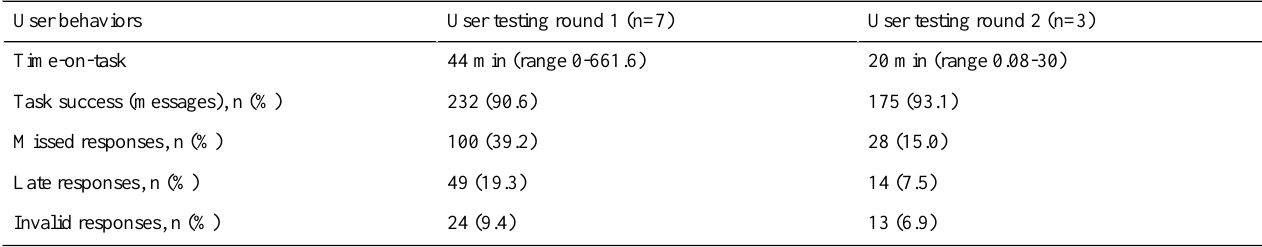
Table 5. Patient text messaging use behavior during user testing.